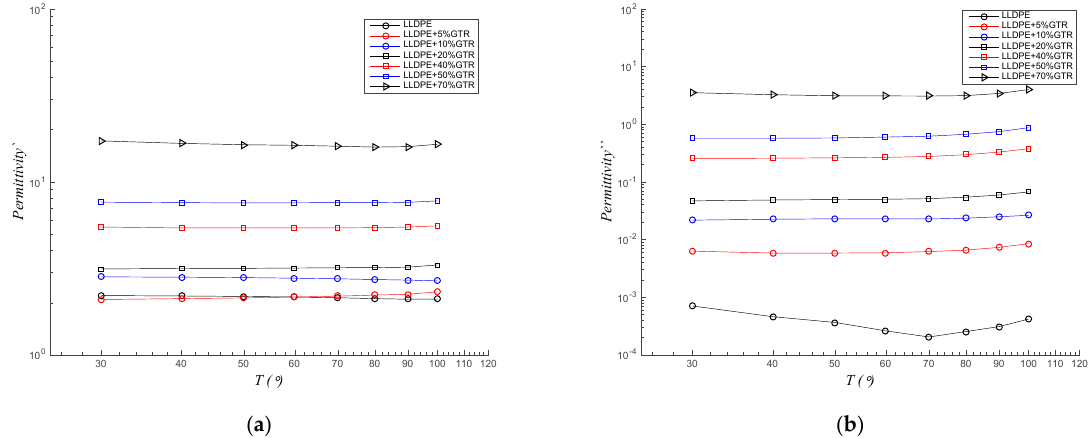
Figure 6. LLDPE/GTR compounds at 50 Hz in relation to temperature (from 30 to 100 °C ); ( a ) real permittivity, Figure 6. LLDPE / GTR compounds at 50 Hz in relation to temperature (from 30 to 100 ◦ C); ( a ) real ε ’; ( b ) ε ’’, dielectric losses factor. permittivity, ε (cid:48) ; ( b ) ε ”, dielectric losses